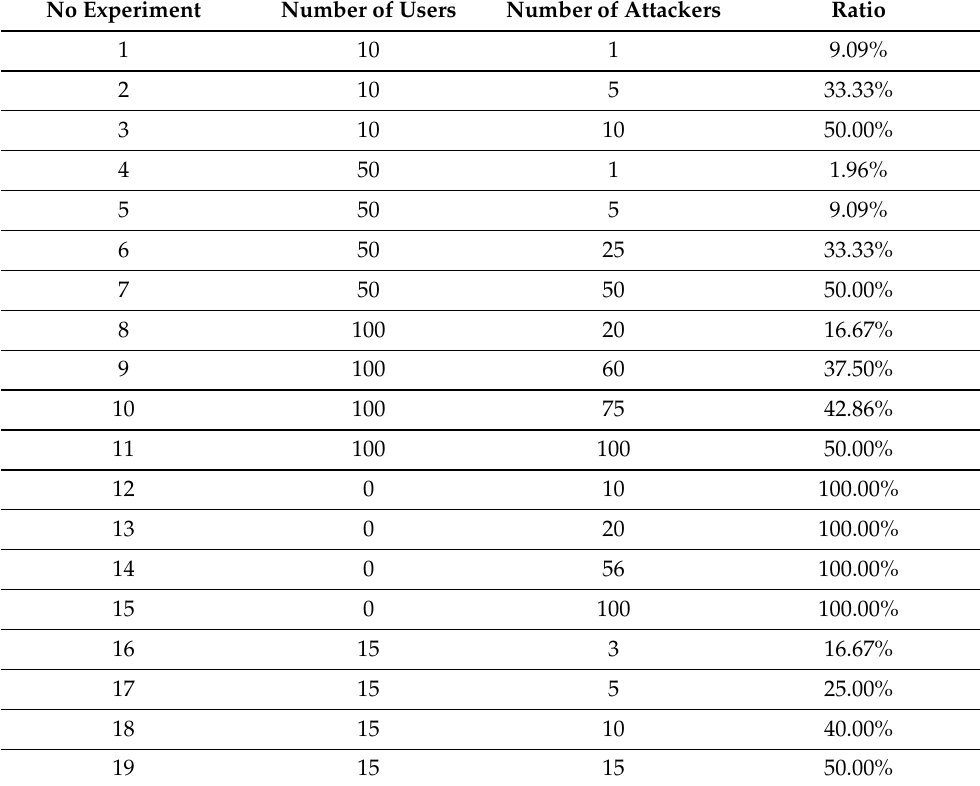
Table 3. Bogus & Sybil Trust Level & Timestamp algorithm—parameters of carried out experiments: the number of users, the number of attackers, and the ratio between victim nodes and attackers. No